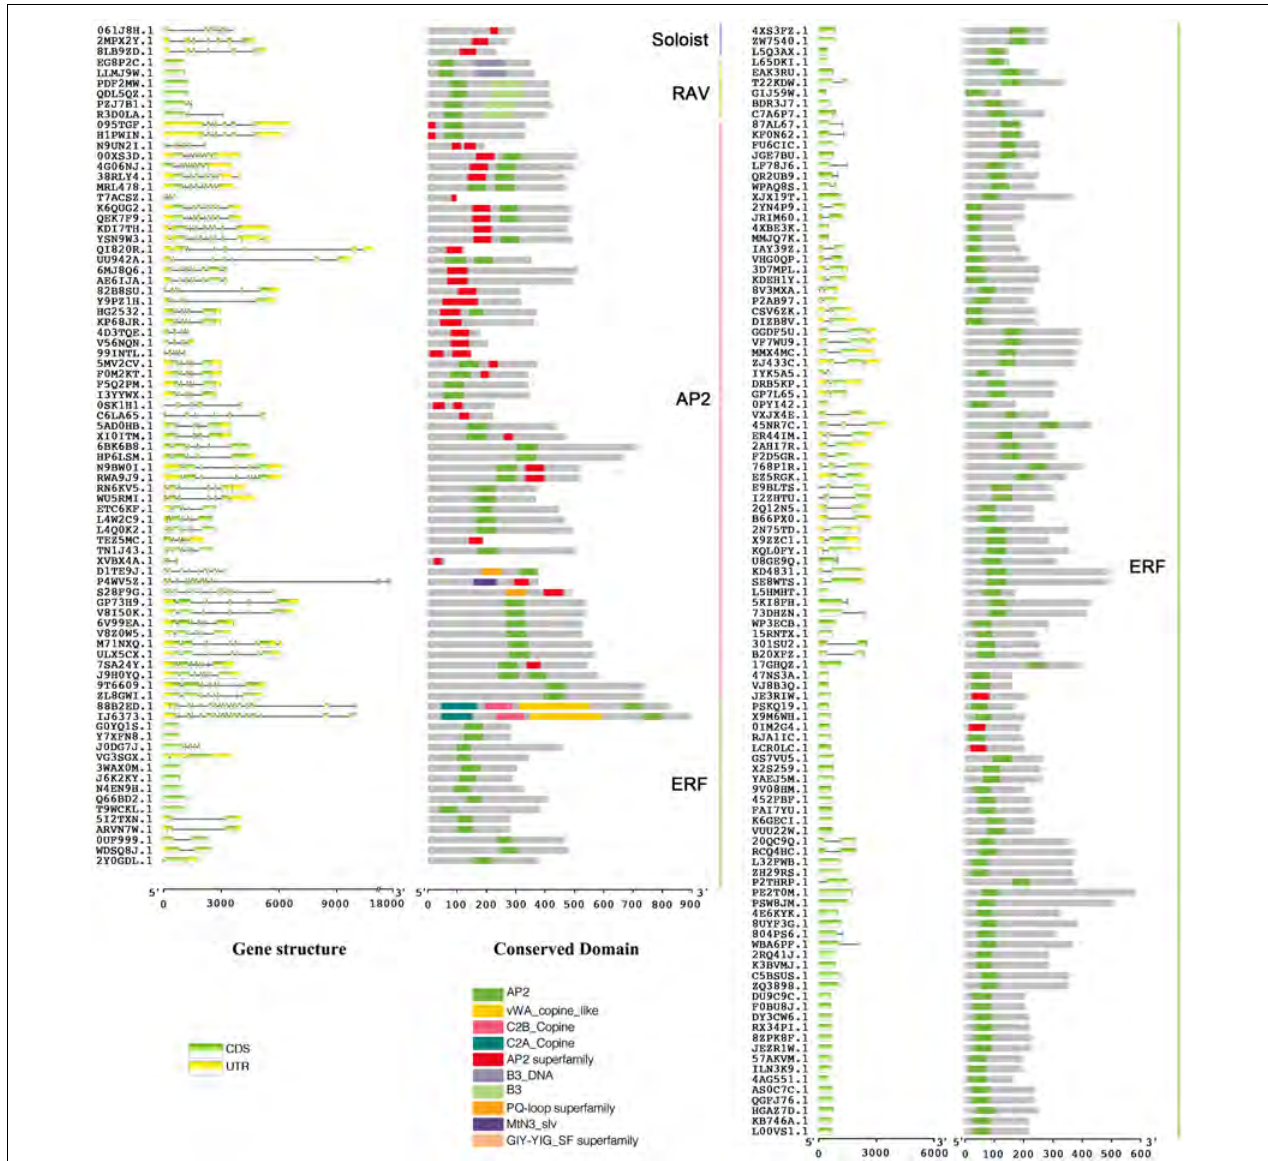
FIGURE 2 | Gene structure and conserved domain of 188 Apetala2/ethylene-responsive factors ( AhAP2/ERF s) in A. hypogaea